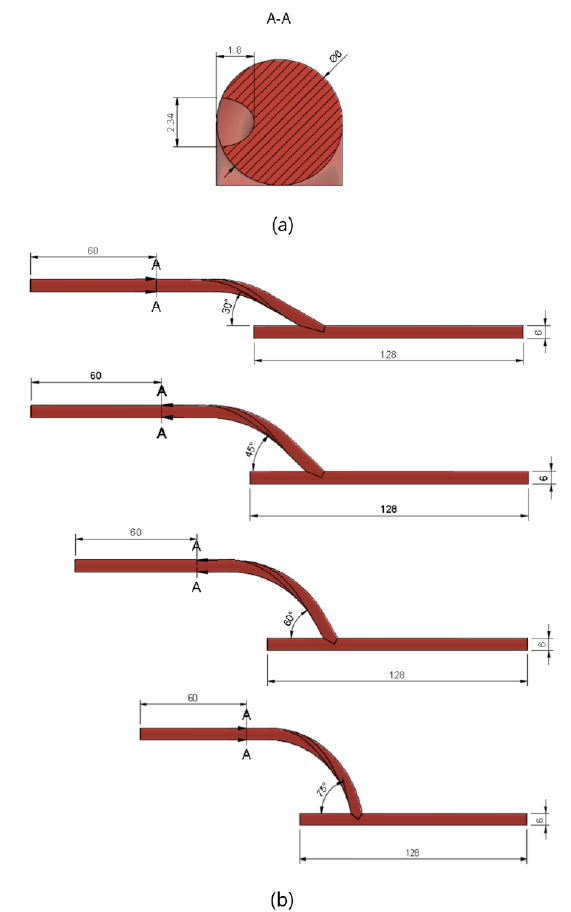
Figure 2. Geometric model used for CFD simulation. ( a ) The cross-sectional profile of the ridged bypass graft; ( b ) model dimensions based on anastomosis